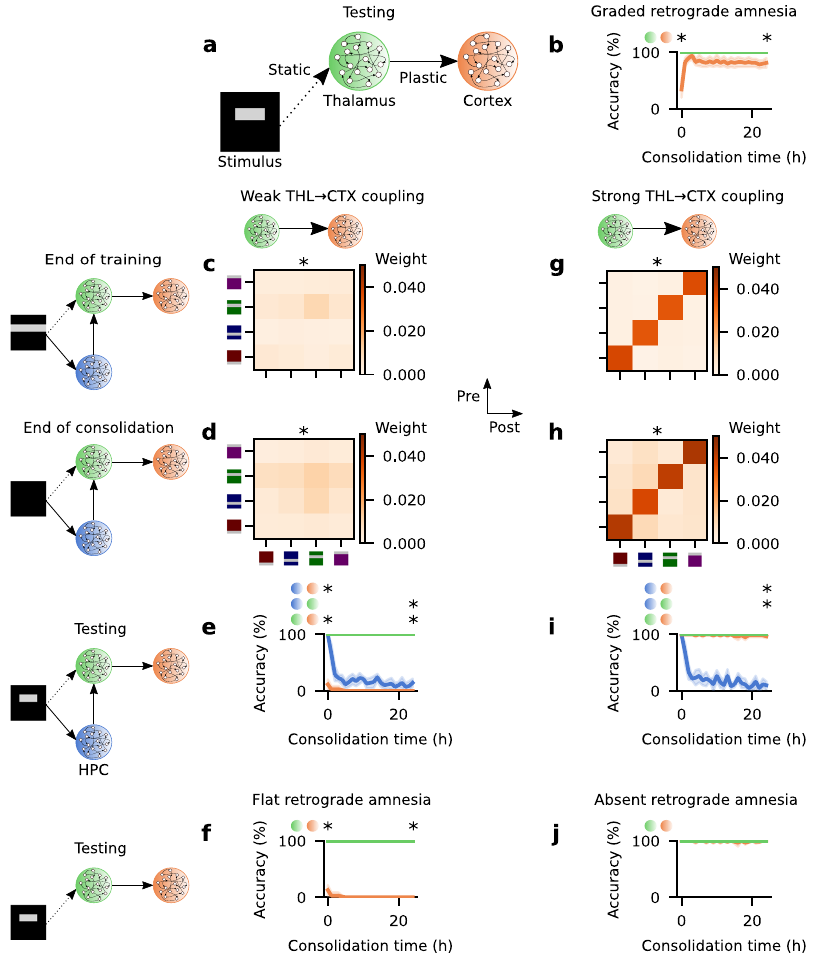
Fig. 5 Thalamocortical coupling at the end of encoding underlies retrograde amnesia pattern. a Schematic of network model with ablation of HPC at testing time. b Memory recall accuracy as a function of consolidation time with HPC ablation in the testing phase (as in a ) of the protocol shown in Fig. 2b.